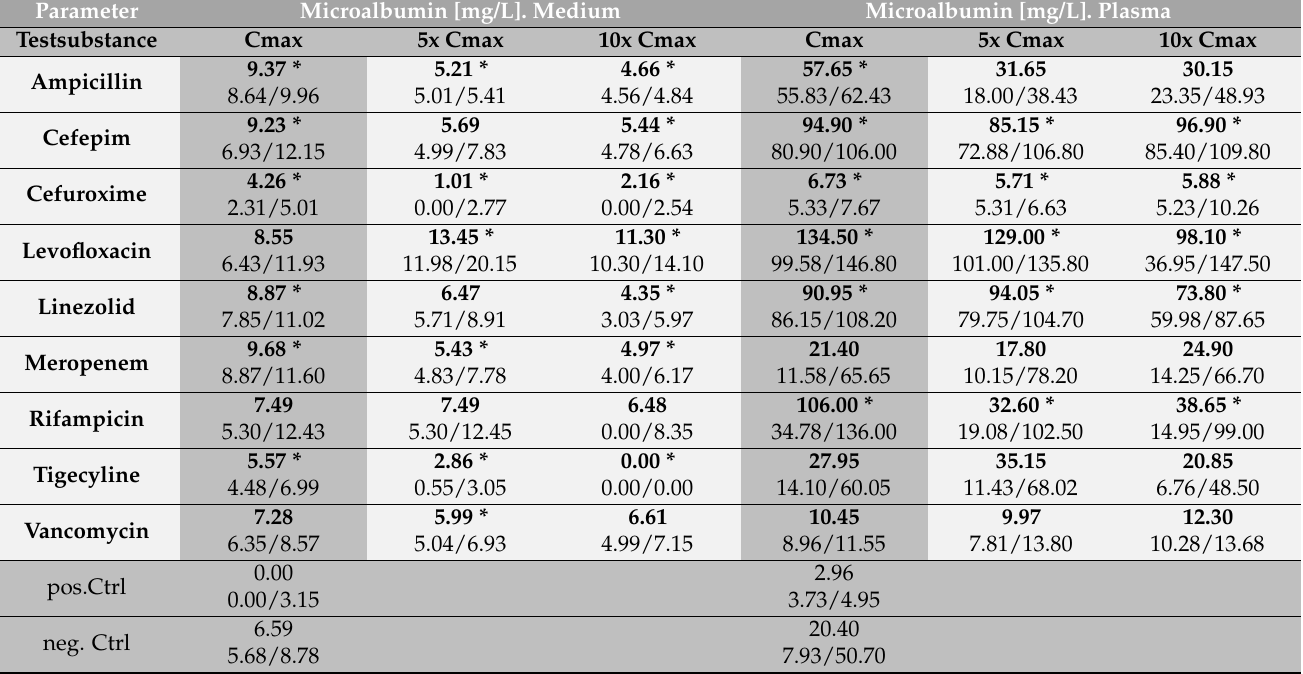
Table 1. Overview of the microalbumin (MA) levels of antibiotic-treated C3A cells in medium (first column) and in plasma (second column) at all tested concentrations. Values represent median